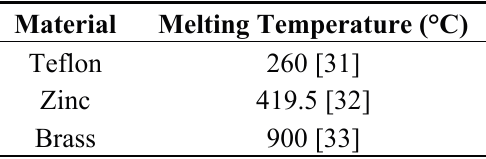
Table 1. Materials used in the construction of the sensor and its respective melting